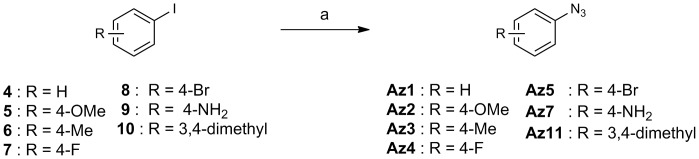
Scheme for the synthesis of Az1–Az5, Az7, and Az11.Reagents and conditions: (a) NaN3, CuI, l-Pro, NaOH, DMSO, 60°C, 37–95%.